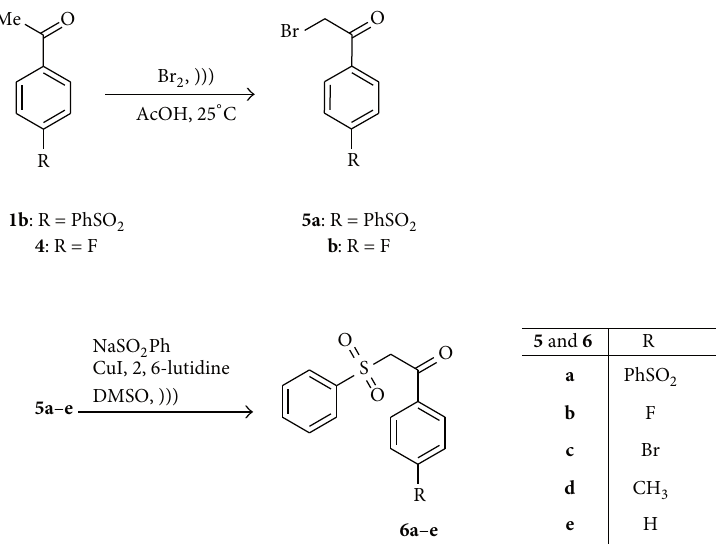
S 3: Synthesis of 2-bromo-1-substituted ethanones 5a,b and 1-substituted 2-(phenylsulfonyl)ethanones 6a–e under ultrasonic irradiation or conventional conditions.